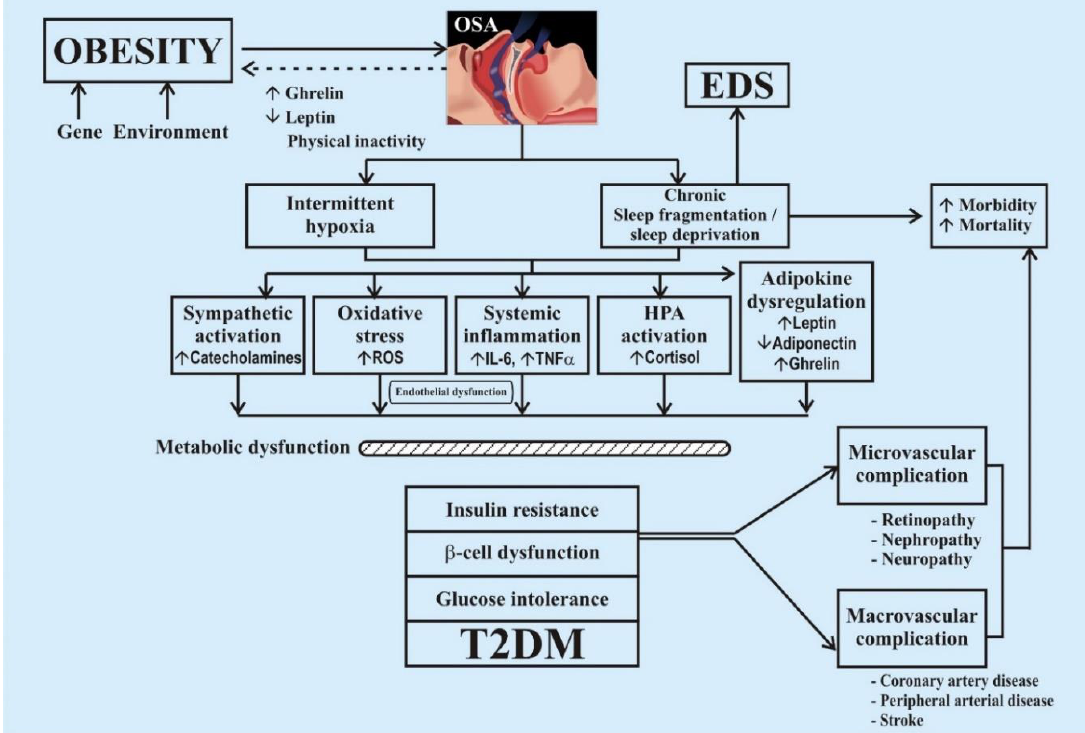
Figure 2. The interconnectedness and pathophysiology of obstructive sleep apnea (OSA) and diabetes. (Abbreviations: EDS: Excessive Daytime Sleepiness; HPA: Hypothalamic Pituitary Adrenal Axis; T2DM: type 2 diabetes mellitus).